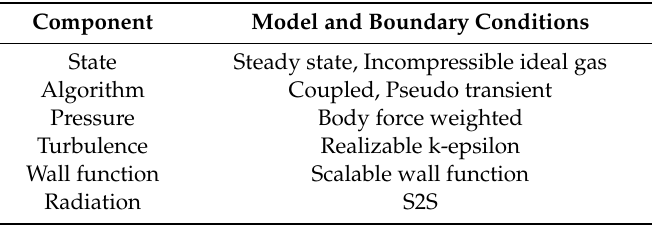
Table 4. Analysis method.